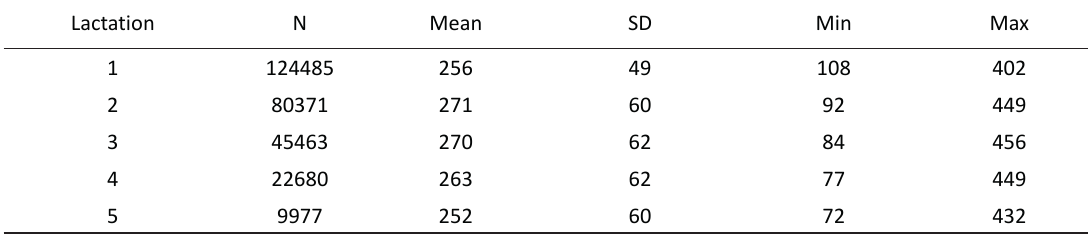
Table 7. Number of observations (N), mean (Mean), standard deviation (SD), minimum value (Min), and maximum value (Max) of the protein yield (kg) Lactation N Mean